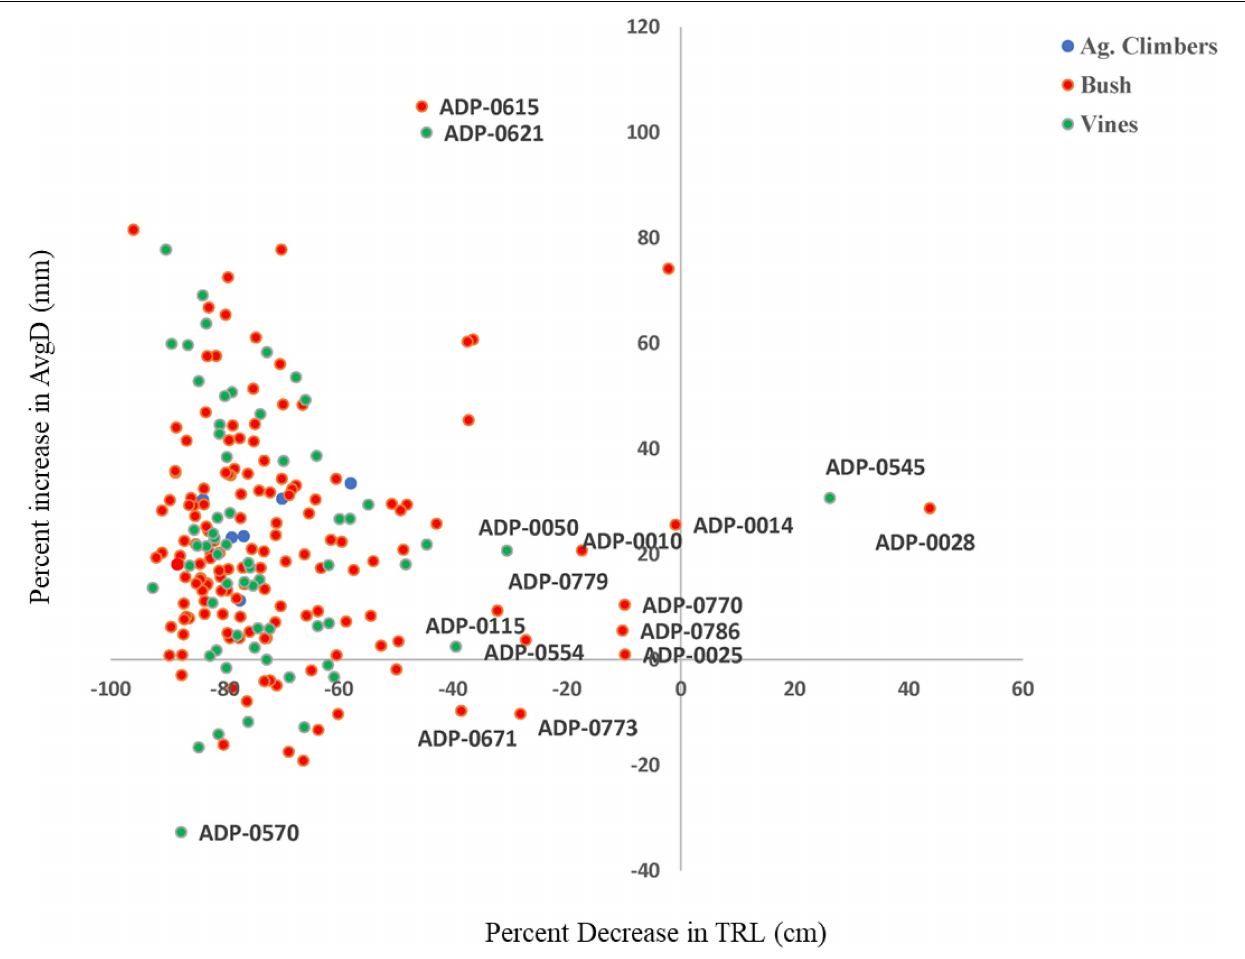
FIGURE 1 | Identification of common bean genotypes from the Andean diversity panel (ADP) with low percent reduction of total root length and Low percent increase in average root diameter